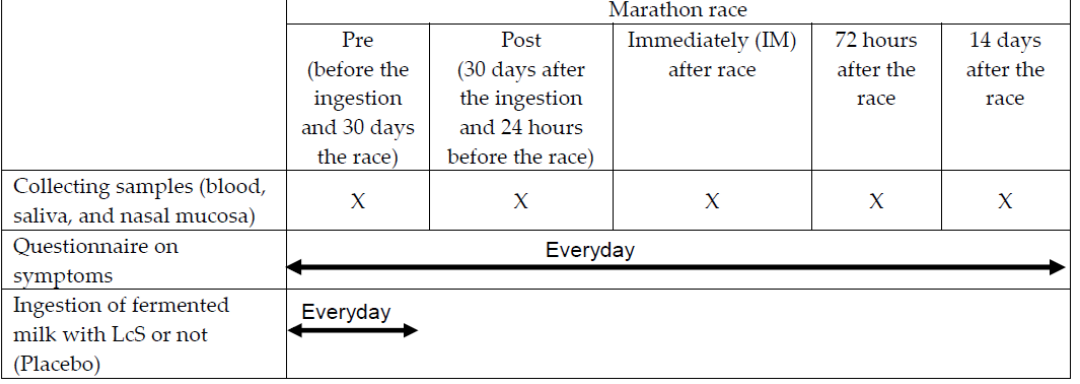
Figure 2. Experimental design.